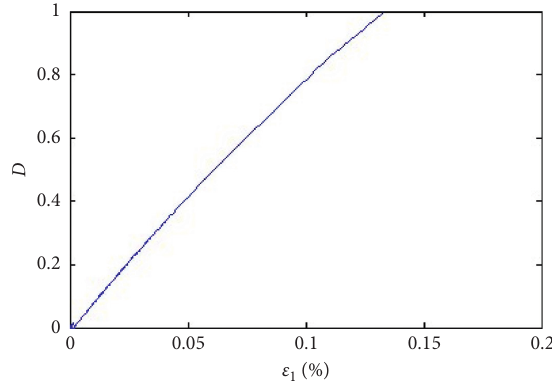
Figure 12: Curves of D ∼ ε 1 of sandstone sample under axial unloading and radial unloading paths.